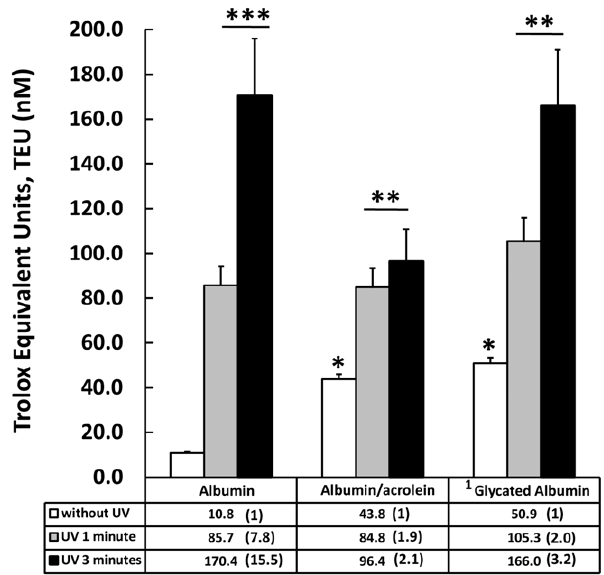
Figure 8. Structural modifications produced by acrolein and glucose on the Antioxidant Capacity (AC) of albumin. Acrolein and glucose partially glycated produce an increase in the AC of albumin of up to 4 times the control native albumin (white bars) value. The exposure of UV (254 nm, 1 and 3 minutes) induces significant increases of AC of albumin exposed with respect to the control. However, the change produced in native albumin was higher than that presented by modified ones. The table below the graph includes the average AC of control samples and treated with UV (values in table without SD), and in parentheses the number of times the antioxidant capacity (AC) of albumin samples were increased in relation to the respective control. Results are expressed as mean 6 SD (n=5). *P , 0.005 vs. control native albumin without UV; **P , 0.005 vs. control (without UV); ***p , 0.001 vs. control (without UV). 1 Partially glycated as described in the Material and Methods section.